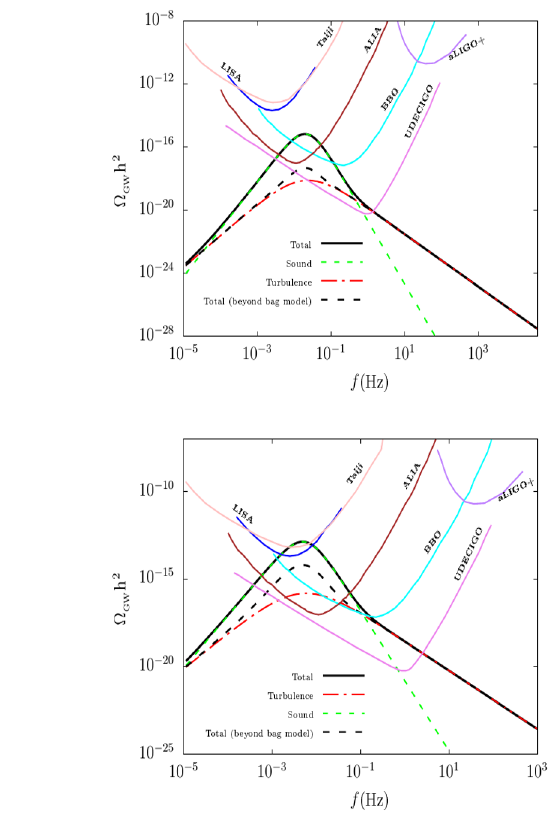
Figure 3. GW energy density spectrum with respect to frequency for the four benchmark scenarios BP-A1 (top, left), BP-A2 (top, right), BP-A3 (bottom, left) and BP-A4 (bottom, right) illustrated against the experimental sensitivity curves of some GW detectors like LISA, Taiji, TianQin, aLigo+, BBO and U-DECIGO. In each plot, the solid black line denotes the total GW energy density within the bag model whereas the broken lines in green and red represent the individual contributions from sound waves (within the bag model) and turbulence, respectively. The broken black lines denote the total GW spectrum beyond the bag